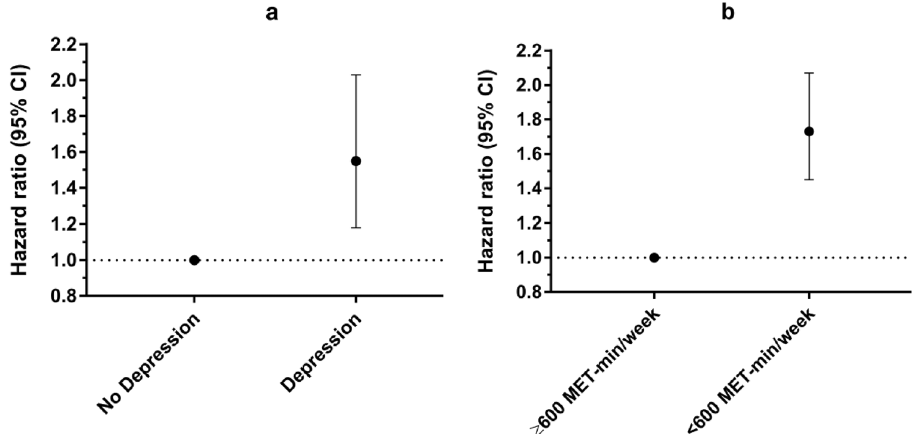
Figure 1. Hazard ratio (95% CI) for all-cause mortality according to ( a ) depression status, and ( b ) physical activity level. Data are representative of non-institutionalized American population. All hazard ratios were adjusted by age, sex, race/ethnicity, annual household income, educational level, alcohol consumption, smoking status, body mass index, arterial hypertension, dyslipidemia, and